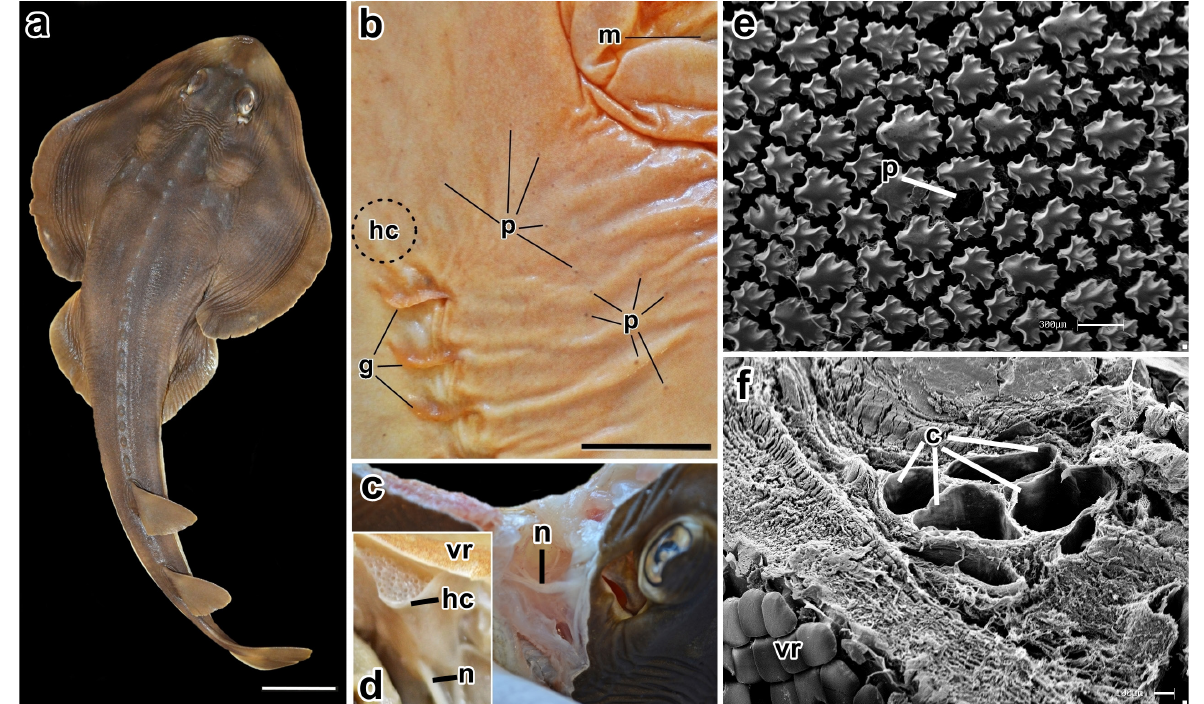
Figure 1 - ( a ) macrograph of the ray Zapteryx brevirostris. ( b ) the ventral region, showing the location and disposition of some pores (p) located near the gills (g) and mouth (m); dashed circulated region, represents the location of hyoid cluster (hc). ( c ) nerve (n) of hyoid cluster. ( d ) hyoid cluster (hc) located next to the gills and nerve (n); ventral region (vr). (e) disposition of the denticles and pores (p) in the skin of the rostral dorsal region, where the denticles around the pores are smaller and differentiated. ( f ) cross section of the rostrum, location in relation to the region ventral skin (vr) and longitudinal arrangement of the ampullae canals (c). Scale bars: ( a ) 5 cm; ( b ) 2 cm; ( e ) 300µm; ( f )